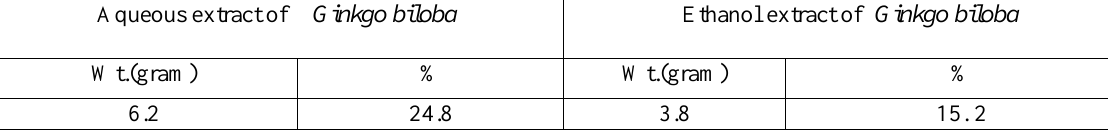
Table 2 . Weight and percentage of aqueous and ethanol of extracts from 25 gram Ginkgo biloba